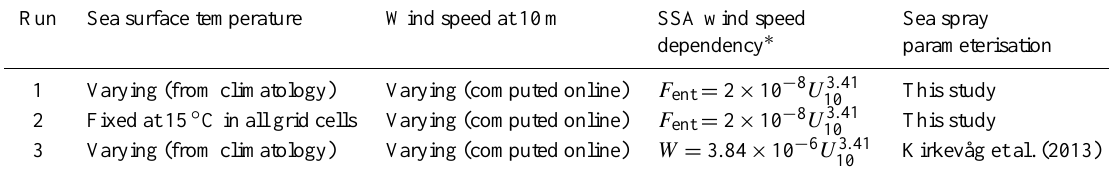
Table 3. Description of the simulated sensitivity experiments conducted in NorESM. The simulated climate was identical in all experiments. Run Sea surface